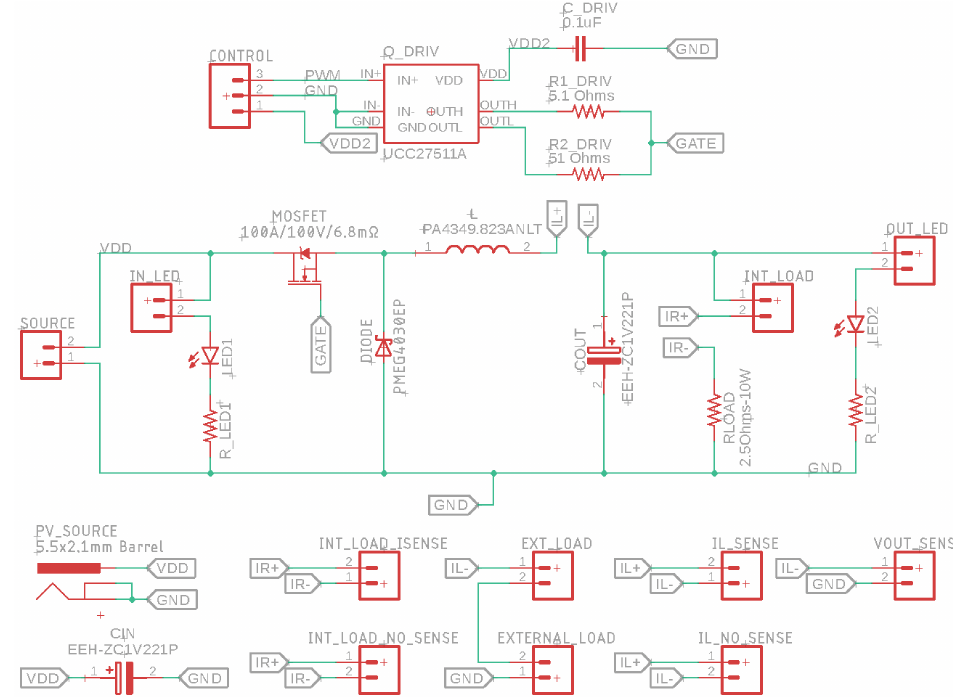
Figure 23. Schematic diagram of the PCB regarding the DC–DC converter optimally designed for the PV